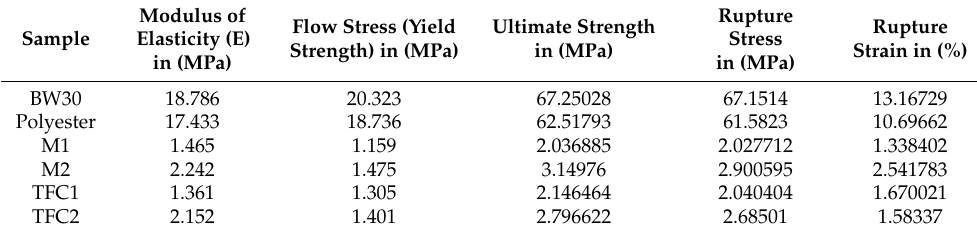
Table 3. Mechanical properties of the different tested 0 ◦ membranes under dry (22 ◦ C)